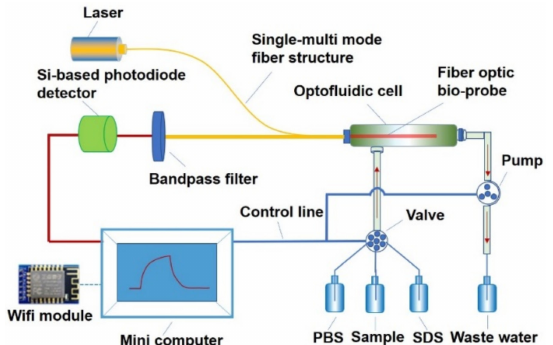
Figure 1. Scheme of the OIP-v2, including the optical system (laser, single-multi mode fiber structure, bandpass filter, and Si-based photodiode detector), the optofluidic system (optofluidic cells and fiber optic bio-probe), the fluidics (pump and valve), and a